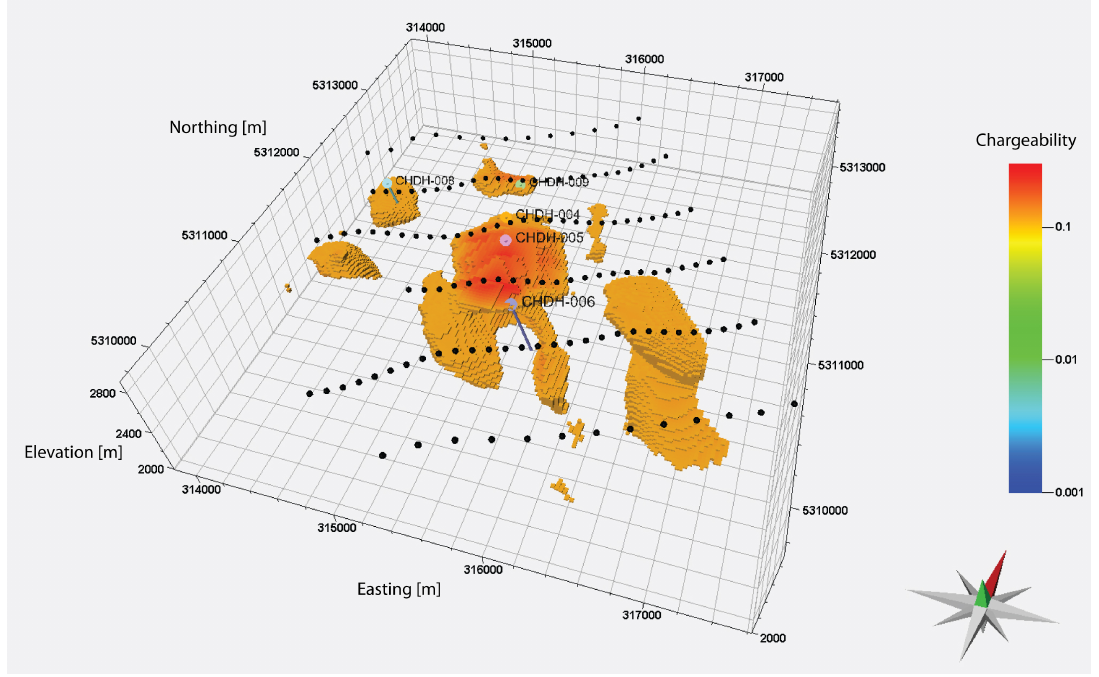
Figure 17. A 3D view of the interpreted target mineralized zones.